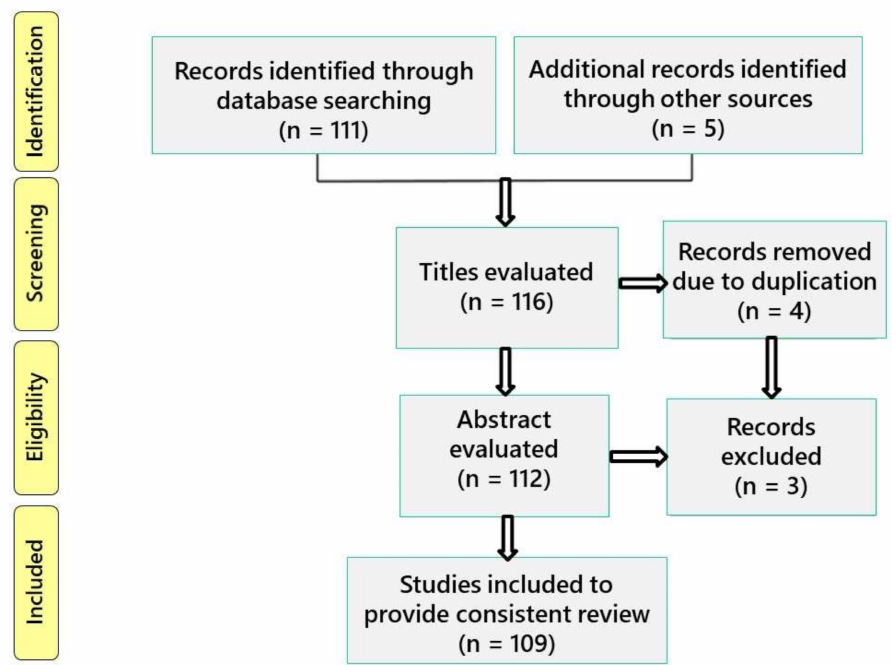
Figure 2. PRISMA flow diagram showing the study selection